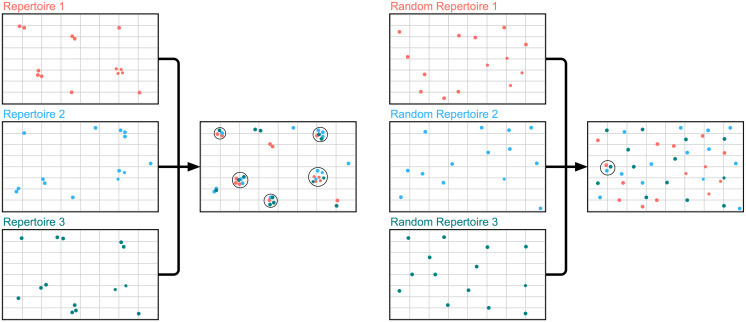
Comparing genuine repertoire snapshots to synthetic ‘Random Repertoires’ (RRs).Each dot represents a distinct structure mapped onto a two-dimensional representation of ‘Length-Accessible Repertoire Structure’ space. The genuine repertoire snapshots of all three individuals (red = repertoire 1, blue = repertoire 2, green = repertoire 3) exhibit focused structural sampling, covering ∼10% of the space as the corresponding RRs. Overlap analysis shows a high proportion of genuine repertoire distinct structures can characterise an Fv in all three individuals (‘public structures’, represented by black circles). When the same overlap analysis is performed on the equivalent ‘Random Repertoires’, far fewer public structures are observed.